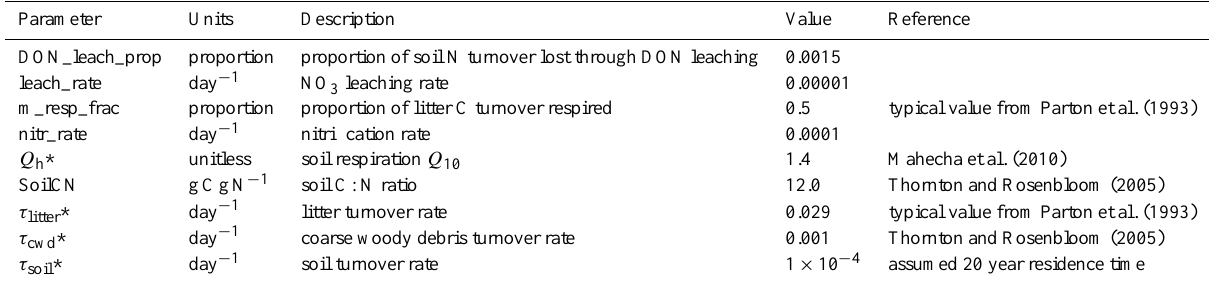
Table 6. Soil Parameters, including units, nominal values and their sources.